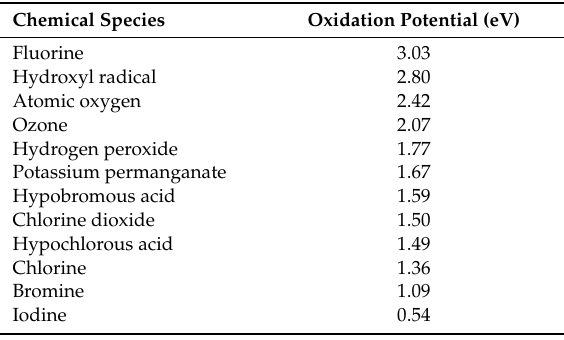
Table 1. Standard oxidation potential of some chemicals species (adapted from